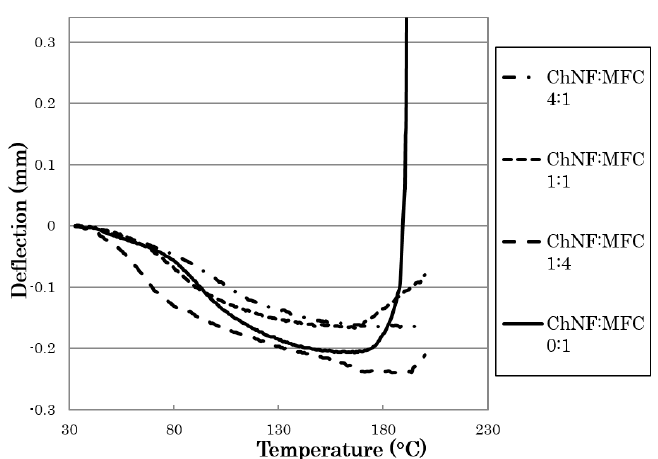
Figure 5. Heat deflection temperature (HDT) curves by the Method B (load of 0.45 MPa) of nanocomposites with 50 wt % reinforcing phase with varying chitin nanofiber (ChNF) to microfibrillated cellulose (MFC) ratios.